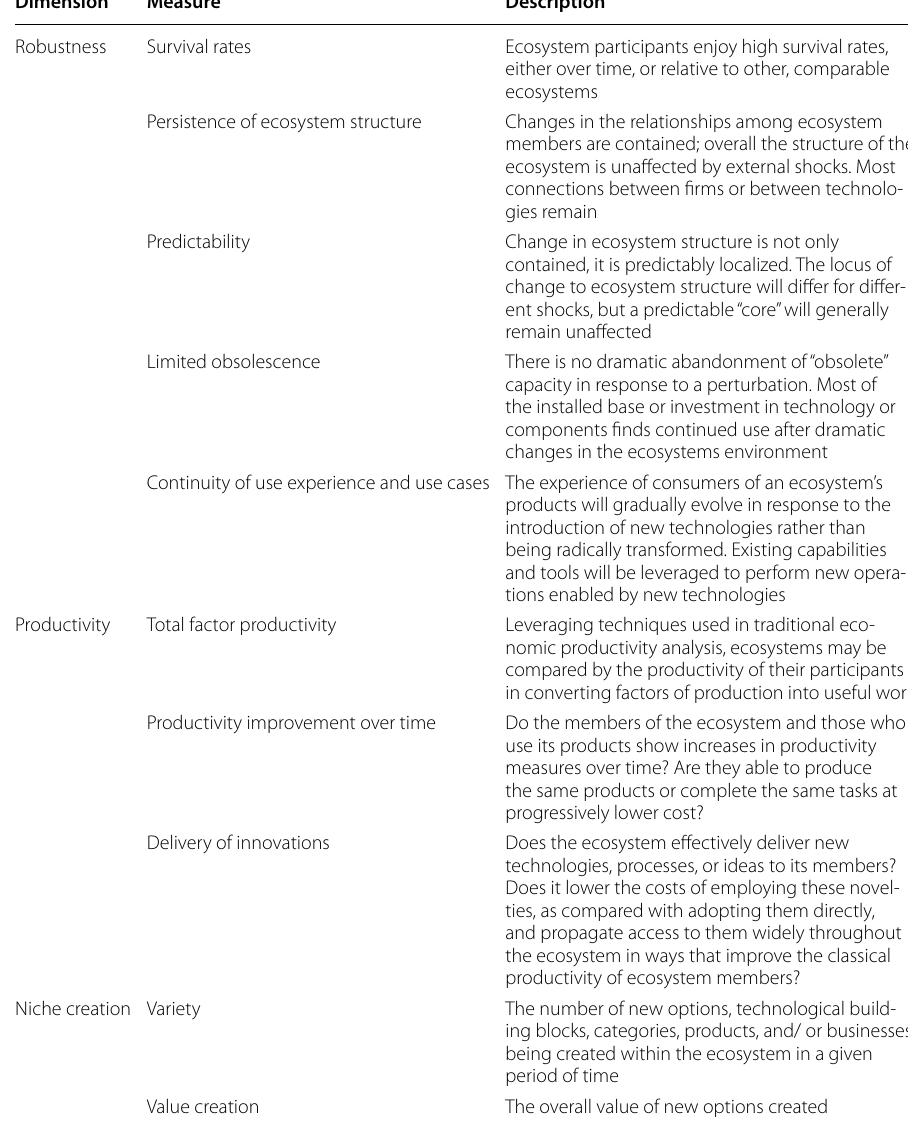
Table 5 The measures of robustness, productivity, and niche creation proposed by Iansiti and Levien